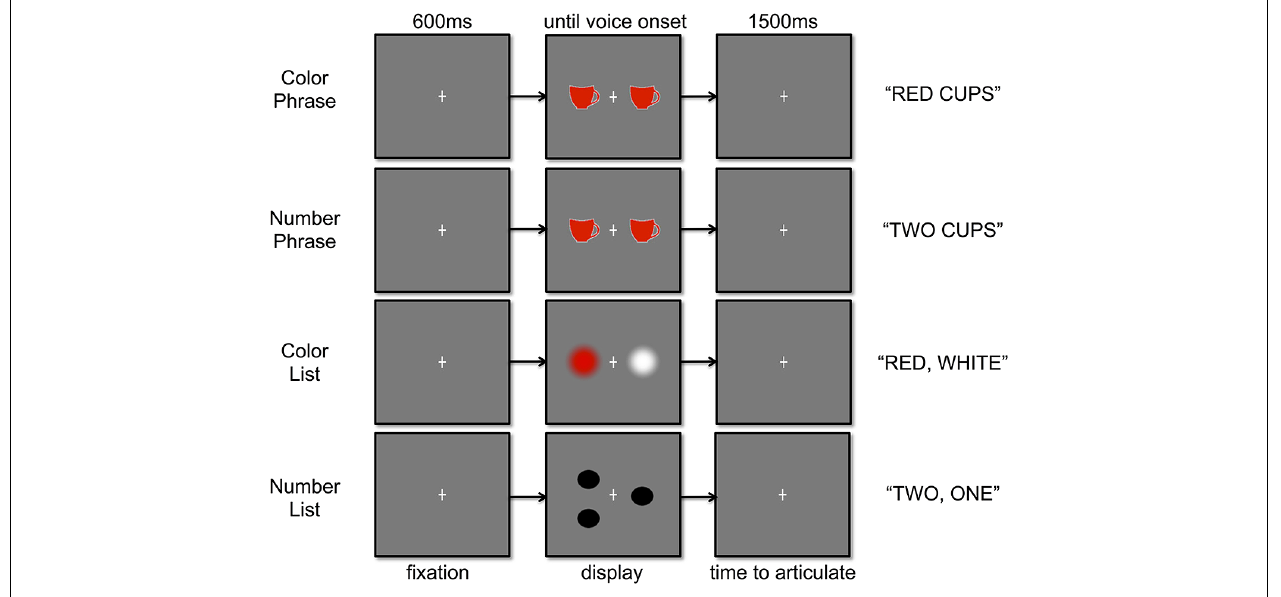
FIGURE 1 |Trial structure and experimental